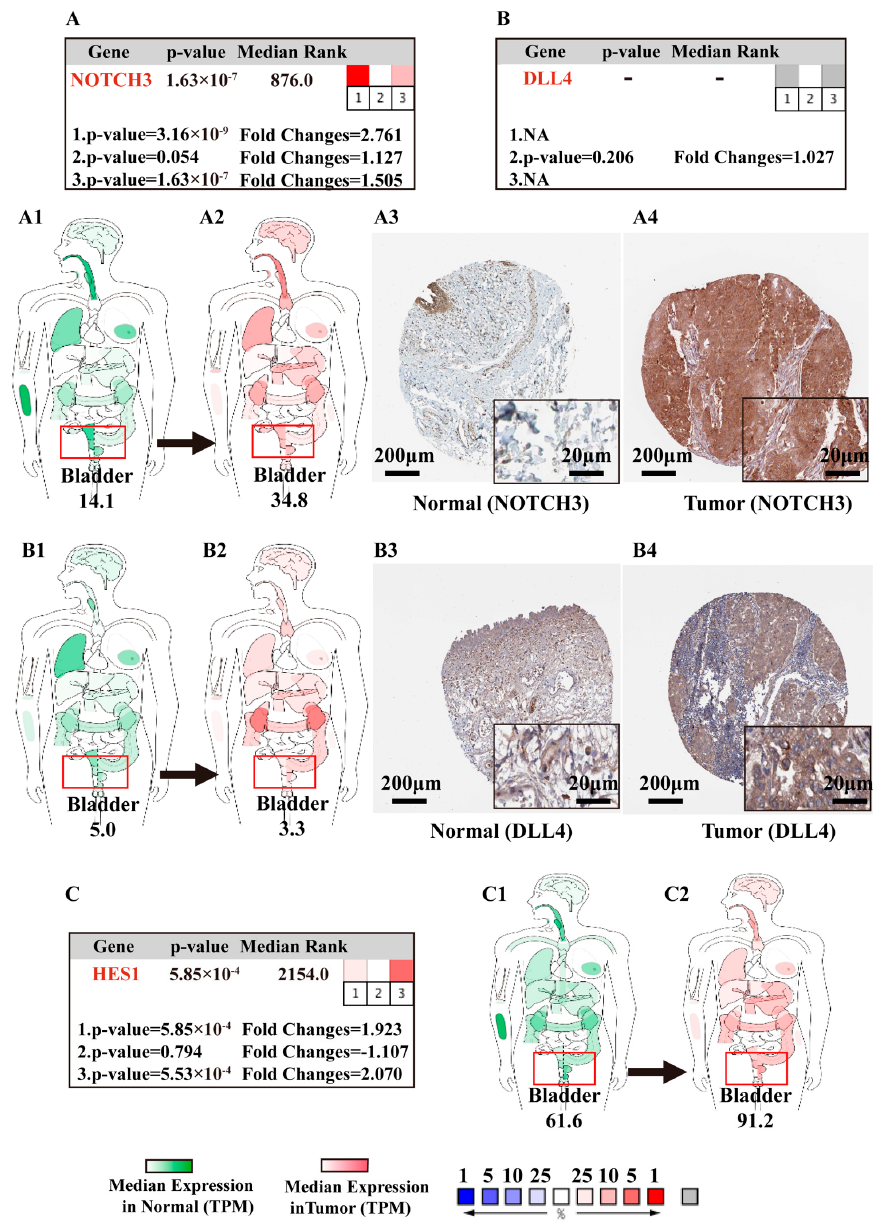
Figure 9. Oncomine meta-analysis of representative genes in BCa vs. non-cancerous tissue, and the body maps depicting the mRNA expression levels of the target genes. (i) Oncomine meta-analysis of NOTCH3 ( A ), DLL4 ( B ), and HES1 ( C ) in BCa vs. non-cancerous bladder tissue (https://www.oncomine.org/, accessed on 13 December 2020) [62]; heat maps of NOTCH3, DLL4, and HES1 demonstrating the gene expression in BCa samples vs. non-cancerous tissues as reported in (1) Dyrskjot et al., Cancer Res , 2004 [69], infiltrating bladder urothelial carcinoma ( n = 13) vs. normal ( n = 14); (2) Lee et al., J Clin Oncol , 2010 [71], infiltrating bladder urothelial carcinoma ( n = 62) vs. normal ( n = 10); (3) Sanchez-Carbayo et al., J Clin Oncol , 2006 [70], infiltrating bladder urothelial carcinoma ( n = 72) vs. normal ( n = 52); right hand: median rank (median rank of the gene across each of the analyses); p -value = p -value for the median-ranked analysis; color of the boxes indicates the percentile of the z-transformed expression level of the gene in the particular study; left hand: p -value reported in each of the studies; NA and the box being filled in gray means not measured in the study. (ii) The median expression of NOTCH3 ( A1 , A2 ), DLL4 ( B1 , B2 ), and HES1 ( C1 , C2 ) in normal tissues (green) and tumors (red) in various organs; body maps constructed on the basis of the GEPIA database (http://gepia.cancer-pku.cn, accessed on 12 November 2020) [58], transcripts per million (TPM). (iii) IHC image credit: Human Protein Atlas (https://www.proteinatlas.org/, accessed on 13 December 2020) [62]; IHC staining of NOTCH3 ( A3 ) and DLL4 ( B3 ) in normal tissue, NOTCH3 ( A4 ) and DLL4 ( B4 ) in cancerous (brown precipitates); no results on HES1 were